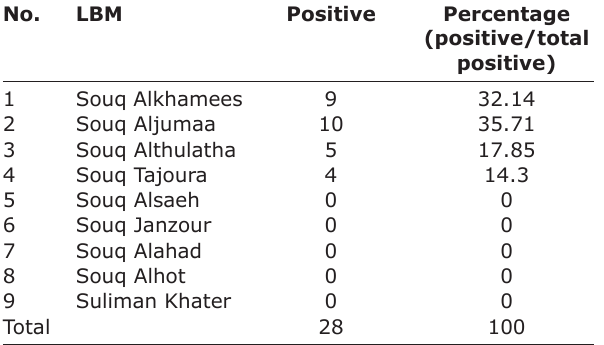
Table-2: The percentage of positive AIV found in each